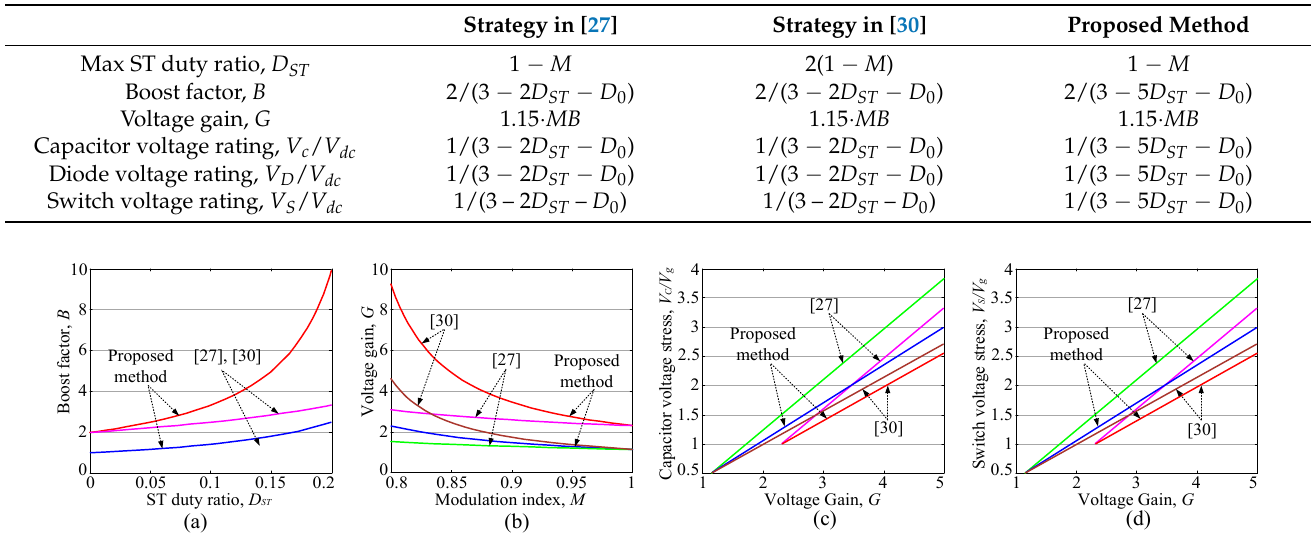
Table 2. Overall comparison study of the proposed method and strategies in [27,30] for 3L-qSBT 2 I.